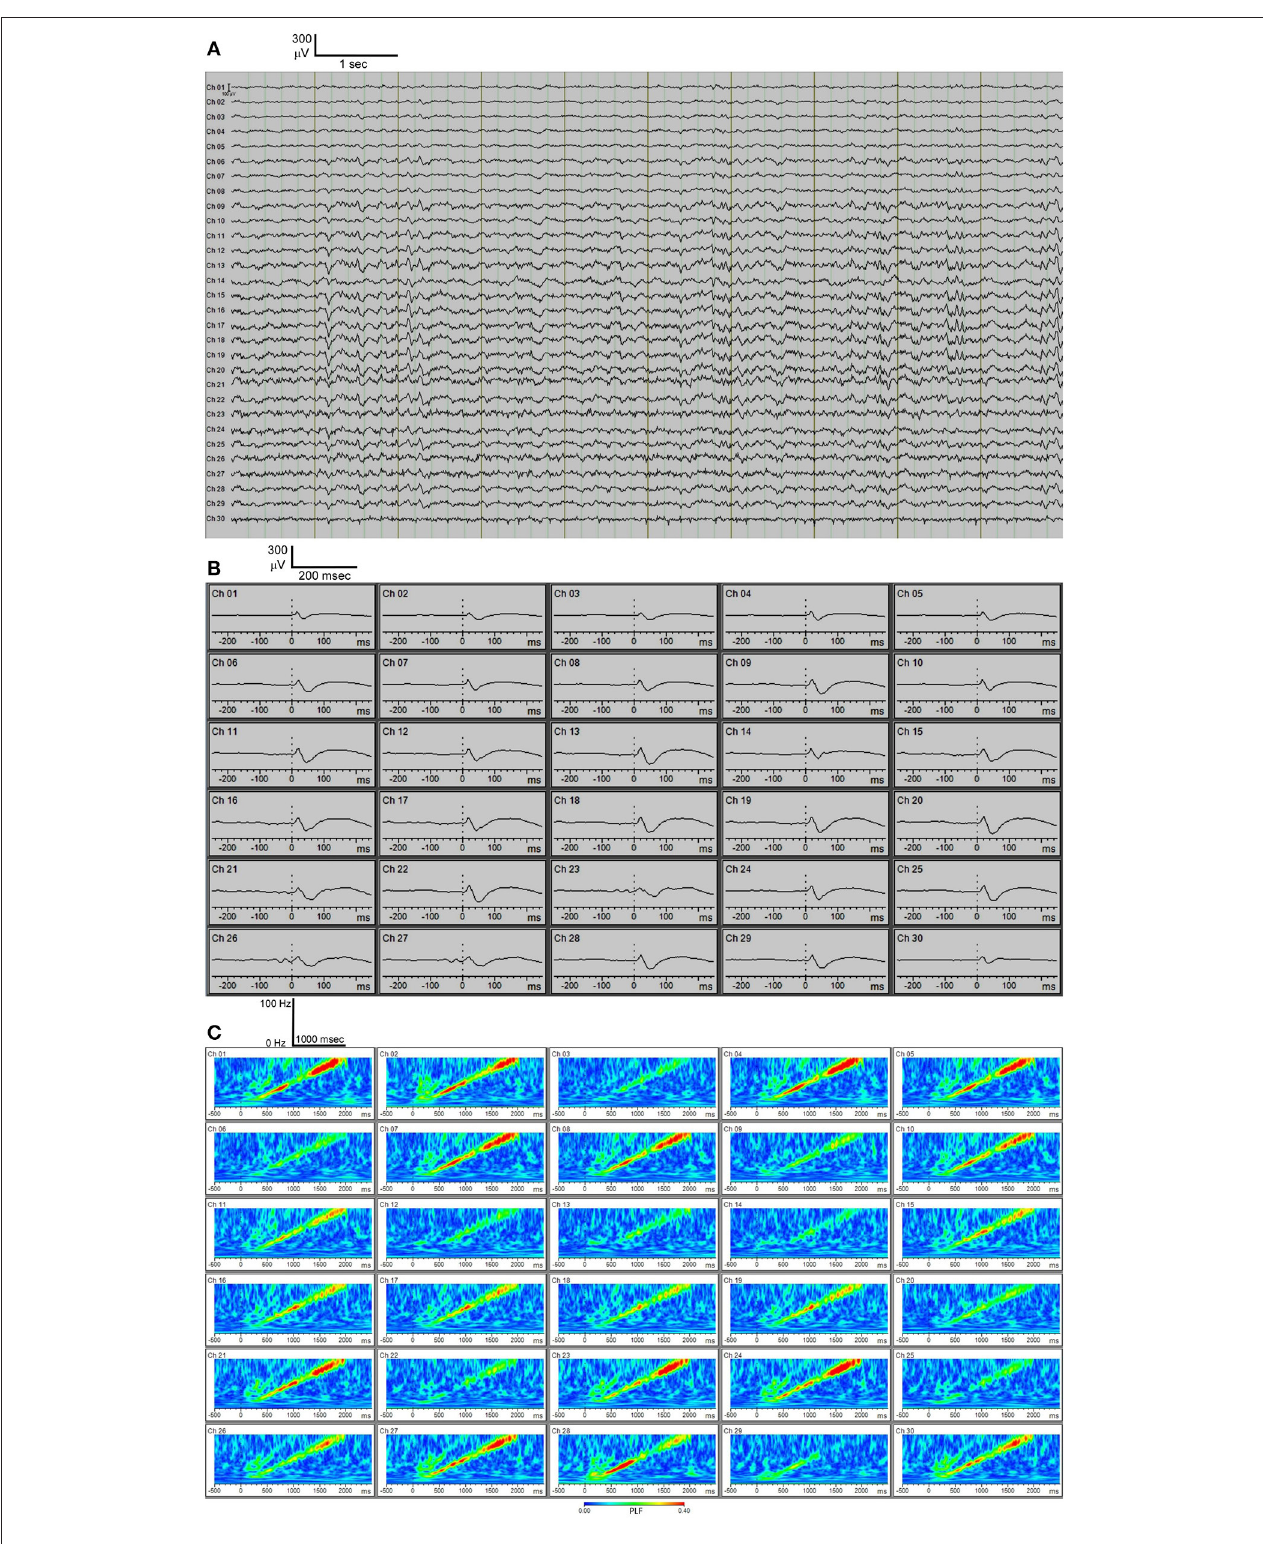
FIGURE 4 | (A) C57BL/6 30-channel baseline EEG. (B) C57BL/6 30-channel auditory event-related potentials (ERPs) showing typical ERP waveforms. (C) C57BL/6 phase-locking factor (PLF) of EEG response to “up chirp” auditory stimulus.